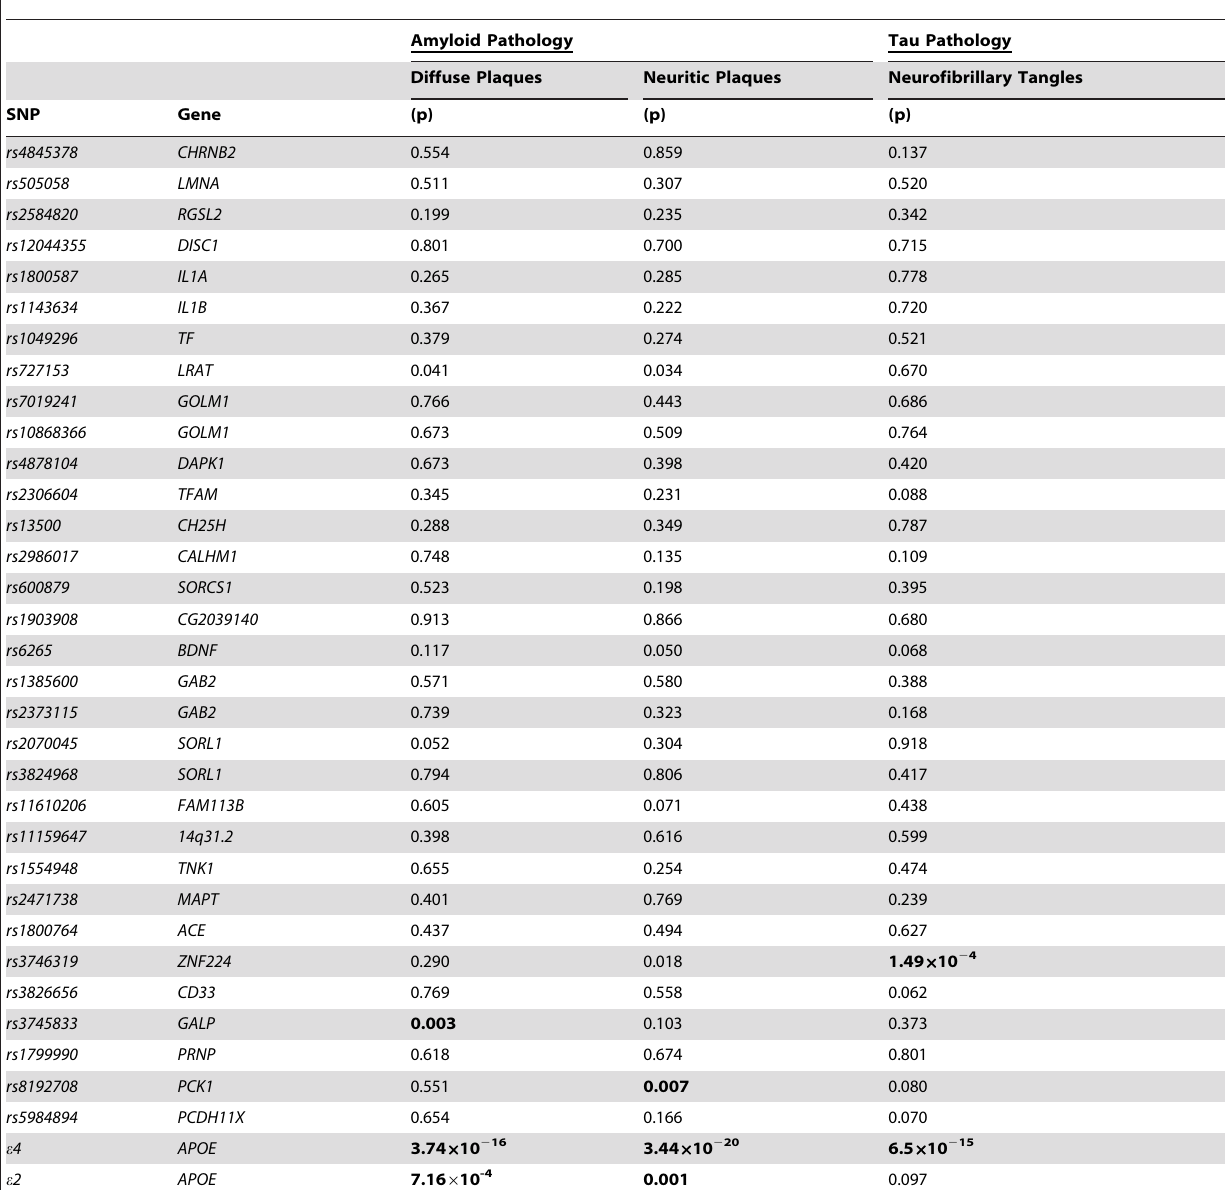
Table 4. Relation of polymorphisms to amyloid plaques and neurofibrillary